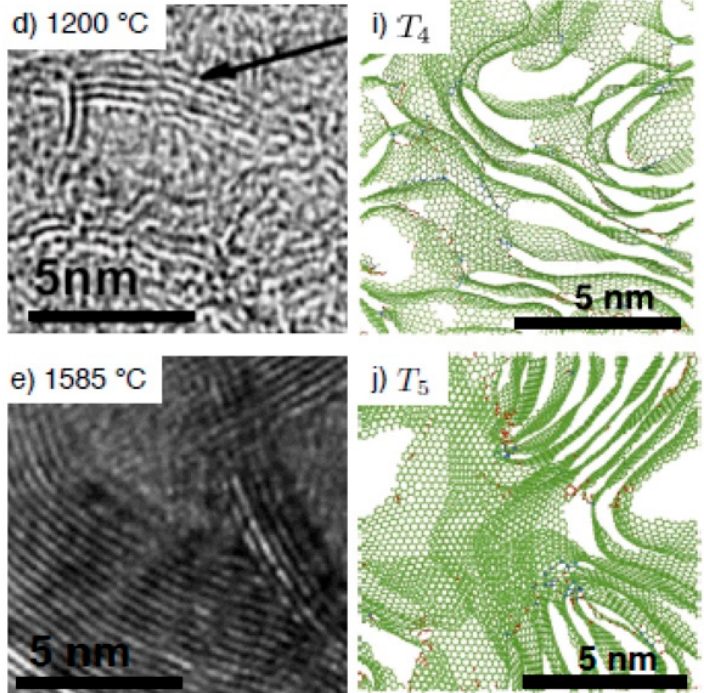
Figure 27. ( a – e ) TEM images of carbide-derived carbons obtained by chlorination at various temperatures. ( f – j ) Structural models of carbide-derived carbons simulated using the annealing-based molecular dynamic approach. Reproduced with permission from Tomas et al. [60]. Copyright